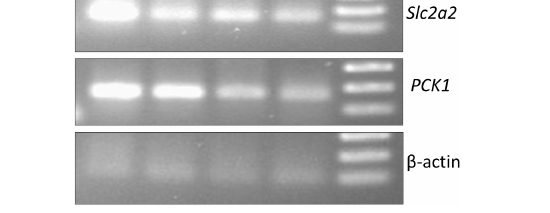
FIGURE7 Effect of ethanolic extract of Solanum torvum fruit on glucose metabolism regulating gene (slc2a, PCK1, and β actin) expression study by reverse transcription-polymerase chain reaction (RT-PCR). NC, negative control; PC, positive control (genomic DNA); IC, internal control; 1, normal control group; 2, diabetic control group; 3, glibenclamide-treated group;